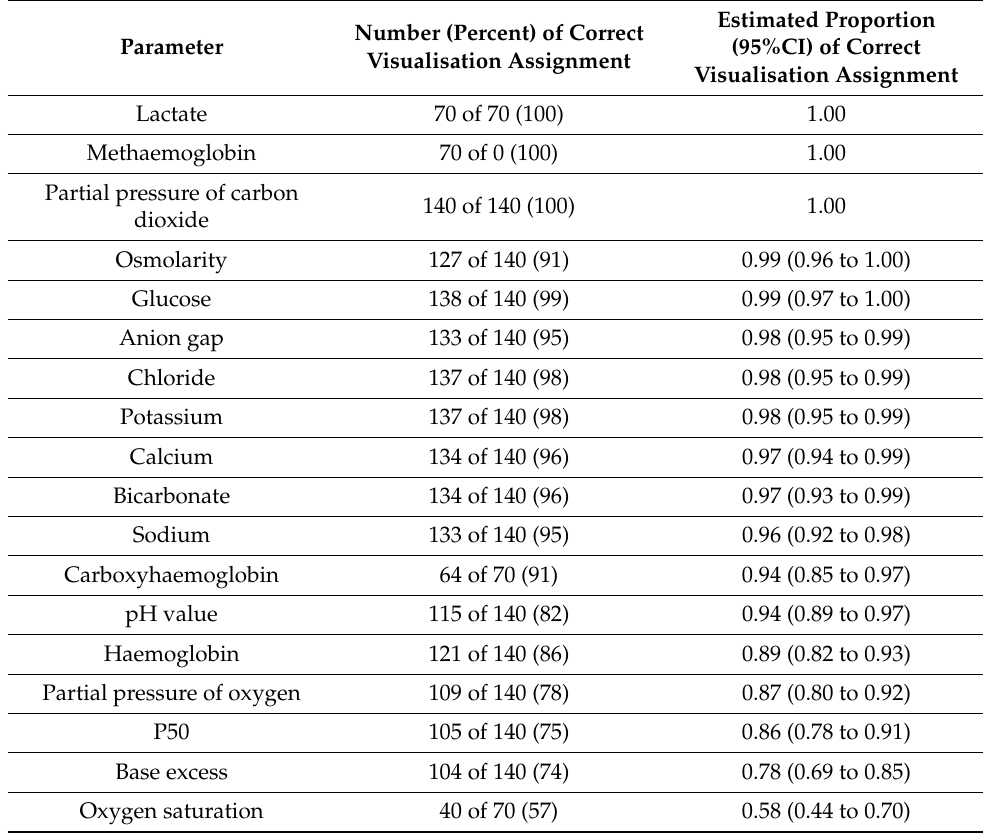
Table 2. Correct visualisation assignments per parameter (=parameter and deviation correctly assigned). Column two shows the numbers and percentages of correct visualisation assignments. Column three shows the estimated proportions according to the mixed logistic regression model per parameter, which considered repeated non-independent measurements from the same persons. Estimated Proportion Number (Percent) of Correct (95%CI) of Correct Parameter Visualisation Assignment Visualisation Assignment Lactate 70 of 70 (100)